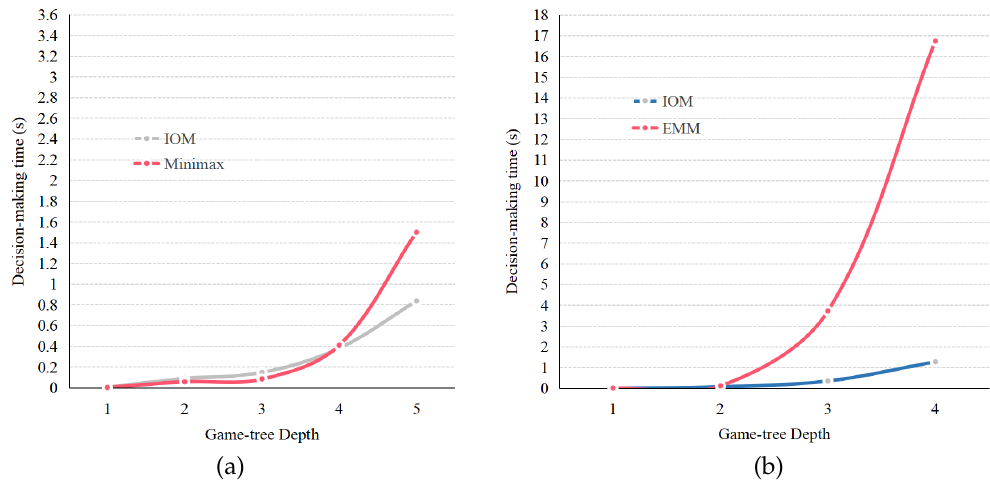
Figure 12. Comparative results on execution time. ( a ) Decision-making time for IOM vs. minimax in Chess. ( b ) Decision-making time for IOM vs. EMM in